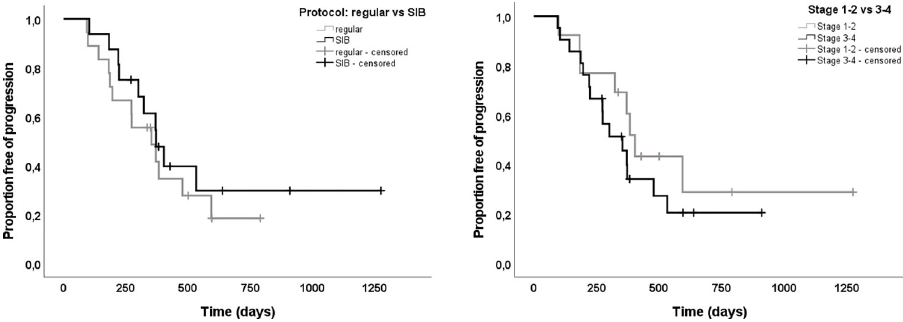
Fig 3. Impact of radiation protocol and tumor stage on time to progression (TTP). Kaplan-Meier plotting, and log- rank test showed no significant difference in TTP between (A) dogs with different radiation protocols (regular (10x4.2 Gy) versus SIB (GTV boosted to 10x4.83 Gy); p = 0.45), and (B) between dogs with different tumor stages (stage 1–2 versus stage 3–4; p = 0.37). Censoring is indicated by tick